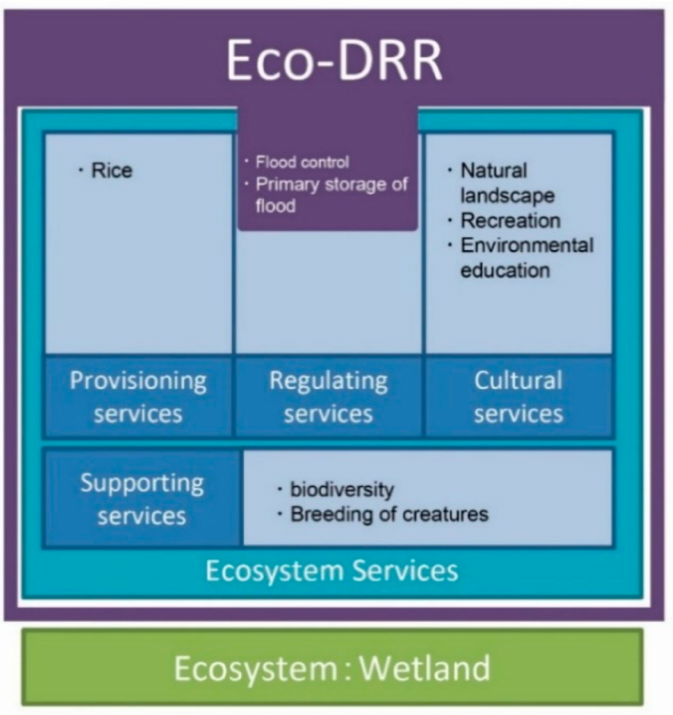
Figure 14. Eco-DRR and ecosystem services at